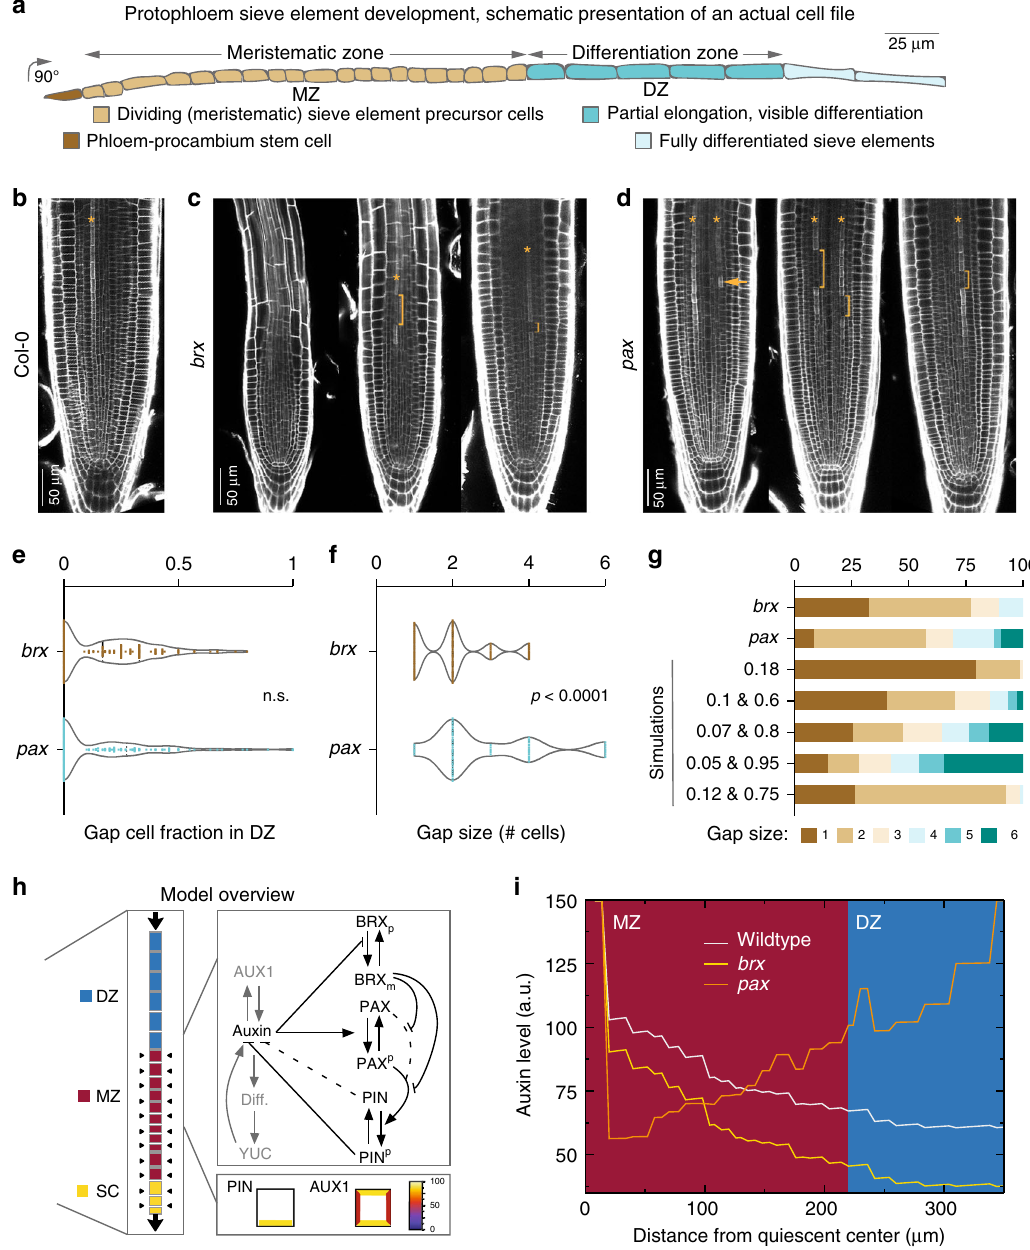
Fig. 1 Antagonistic auxin ef fl ux impairments trigger similar non-random protophloem differentiation failures. a Schematic overview of a developing protophloem sieve element (PPSE) cell fi le in the Arabidopsis root meristem. b Confocal microscopy image of a 7-day-old wild type (Col-0) root meristem, propidium iodide (PI) cell wall staining (protophloem cell fi le marked by an asterisk, as hereafter). c , d Phenotypic range of brx or pax mutant